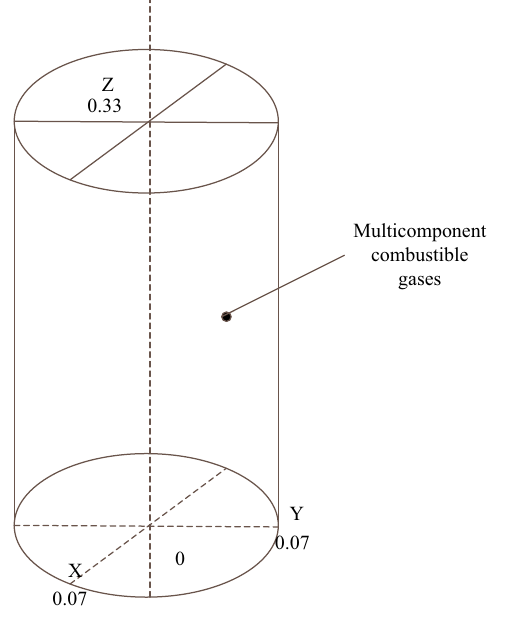
Figure 1: A 5 L cylindrical tank model.